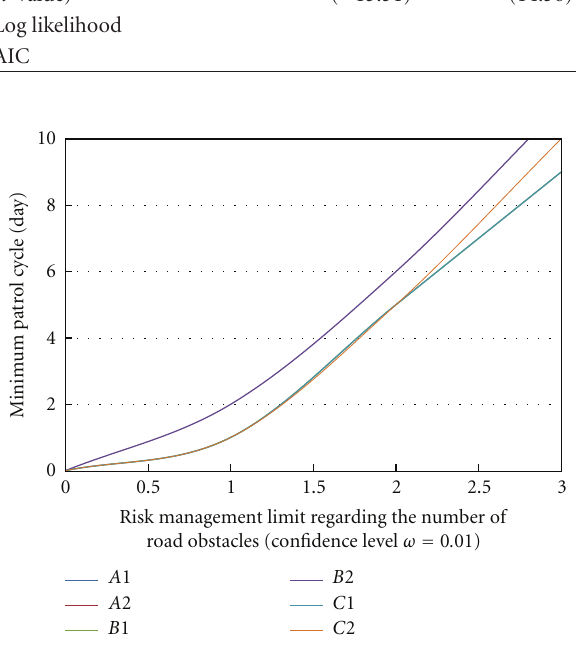
Figure 4: Risk management limit (number of road obstacles) and the minimum patrol cycle (confidence level ω = 0 . 01).